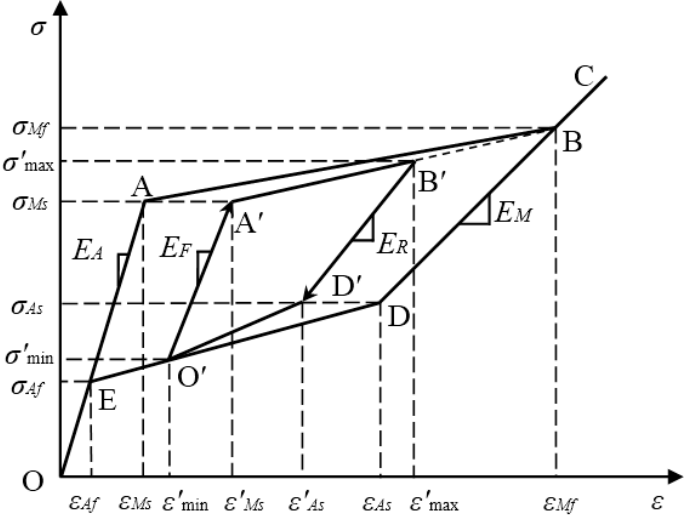
Figure 2. Schematic of the hysteresis curve model of the subloop.